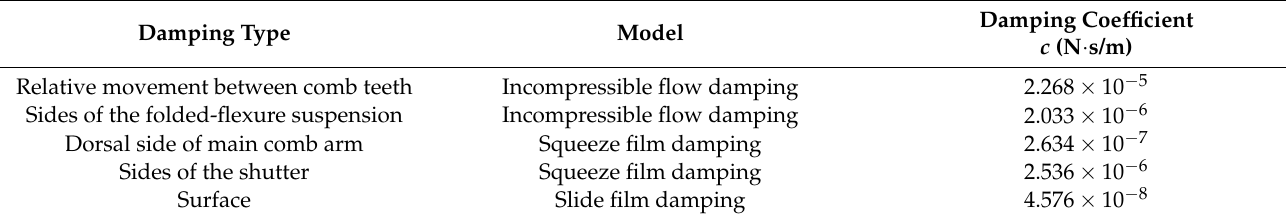
Table 3. Calculation results of viscous damping at resonance.